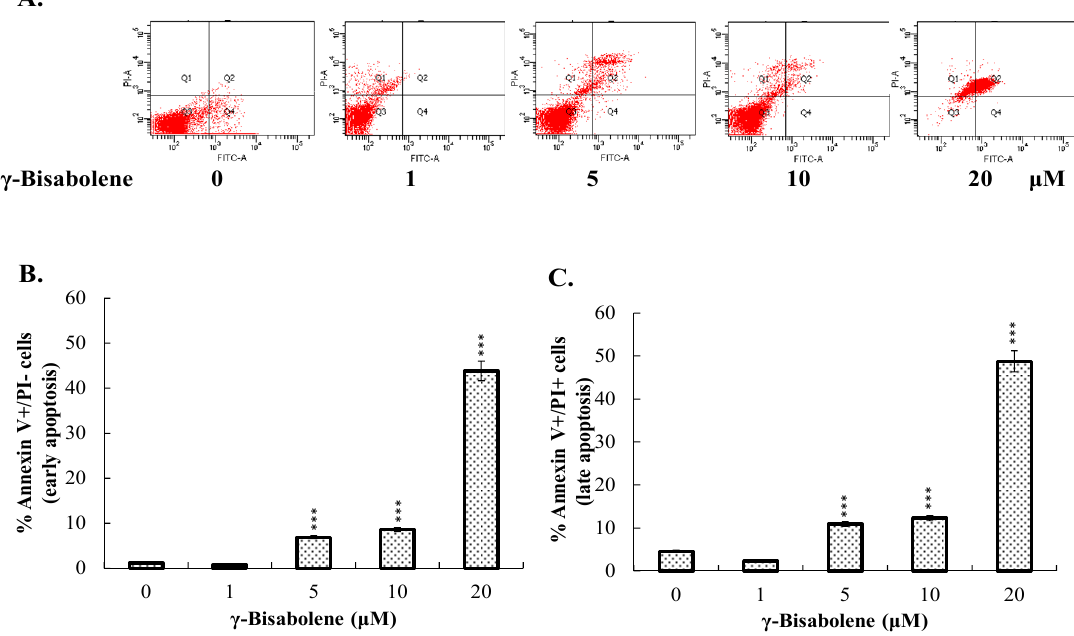
Figure 2. Apoptosis analysis of human neuroblastom cells in responses to γ -bisabolene. Cells were harvested 48 h post treatment, stained by Annexin V-FITC/PI dye, and then analyzed using flow cytometry ( A ); Annexin V positive/PI negative indicated early phase of apoptosis ( B ); Annexin V positive/PI positive presented as late apoptosis ( C ). ***, p value < 0.001 compared with untreated cells.